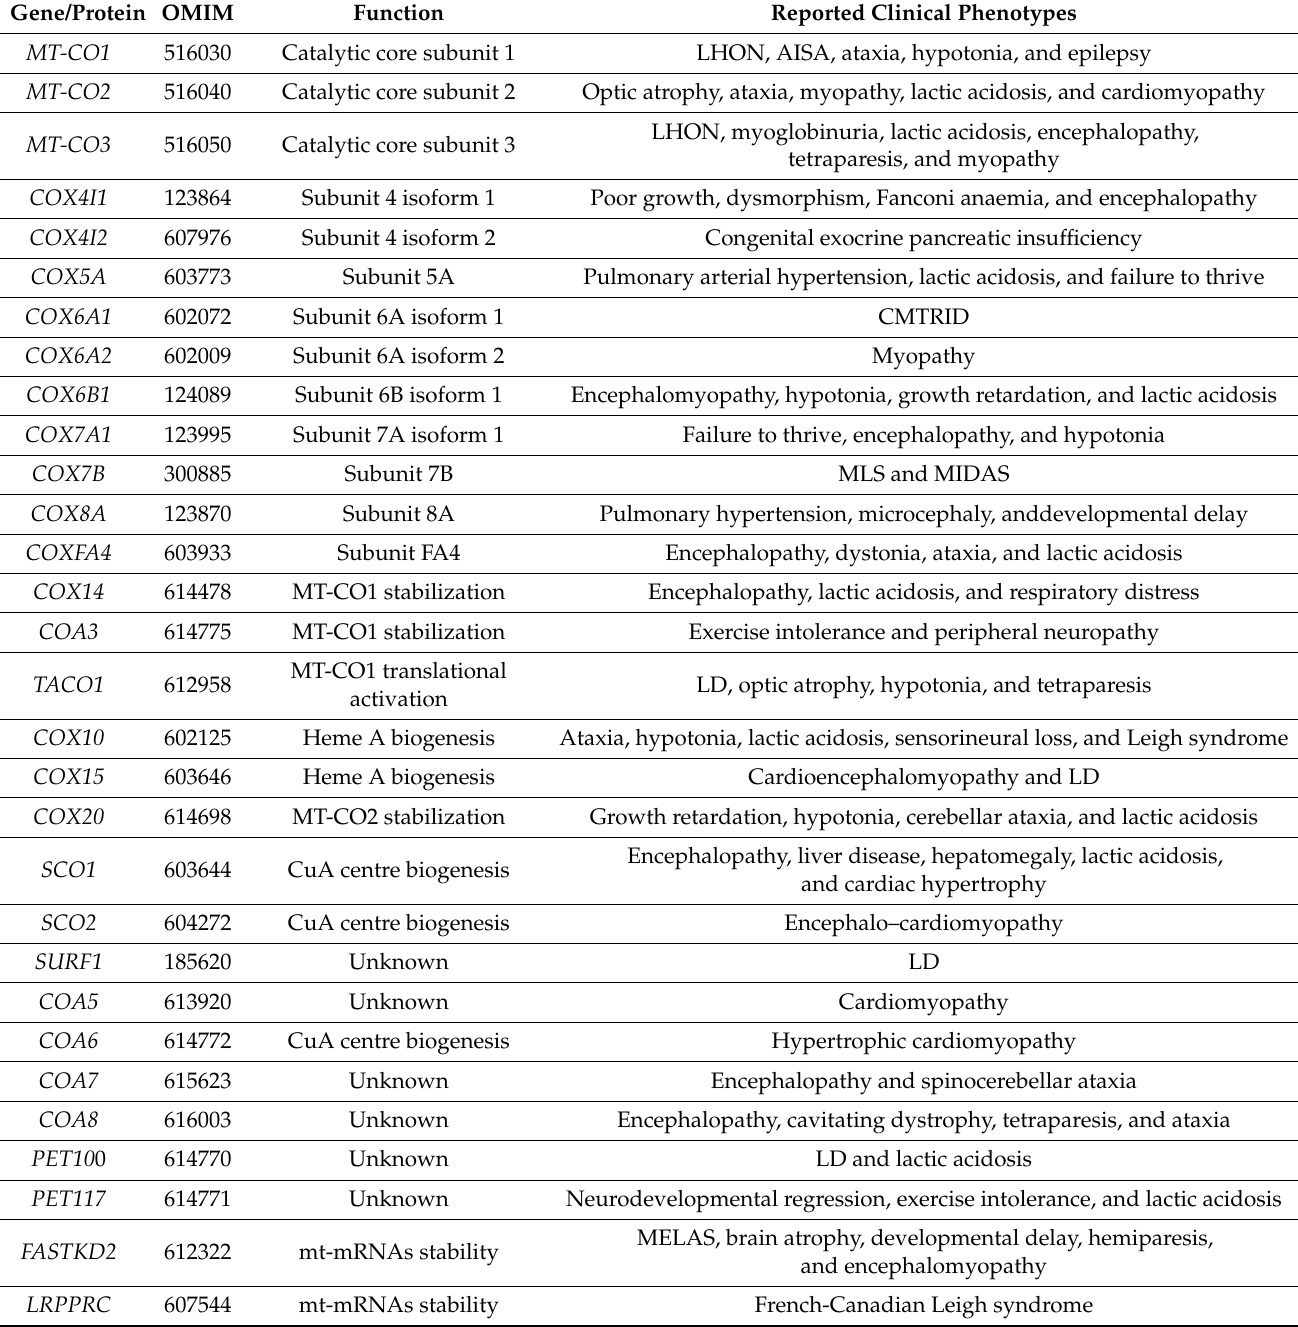
Table 4. Mutations associated with mitochondrial CIV deficiency. Adapted from